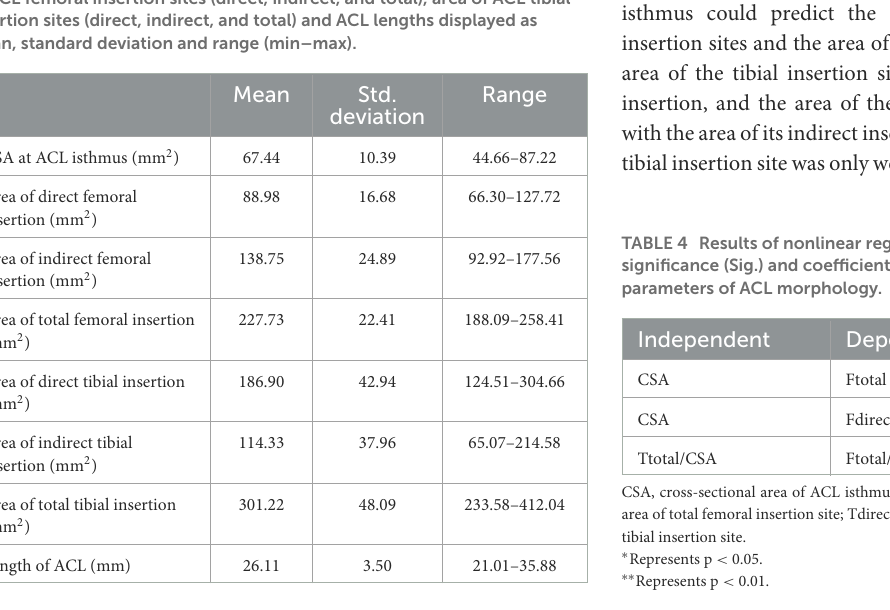
TABLE 3 Results of nonlinear regression analysis showing statistical significance (Sig.) and coefficient of determination ( R 2 ) representing consistency between the best-fit line and the raw data, with each measured parameter used as a single variation.